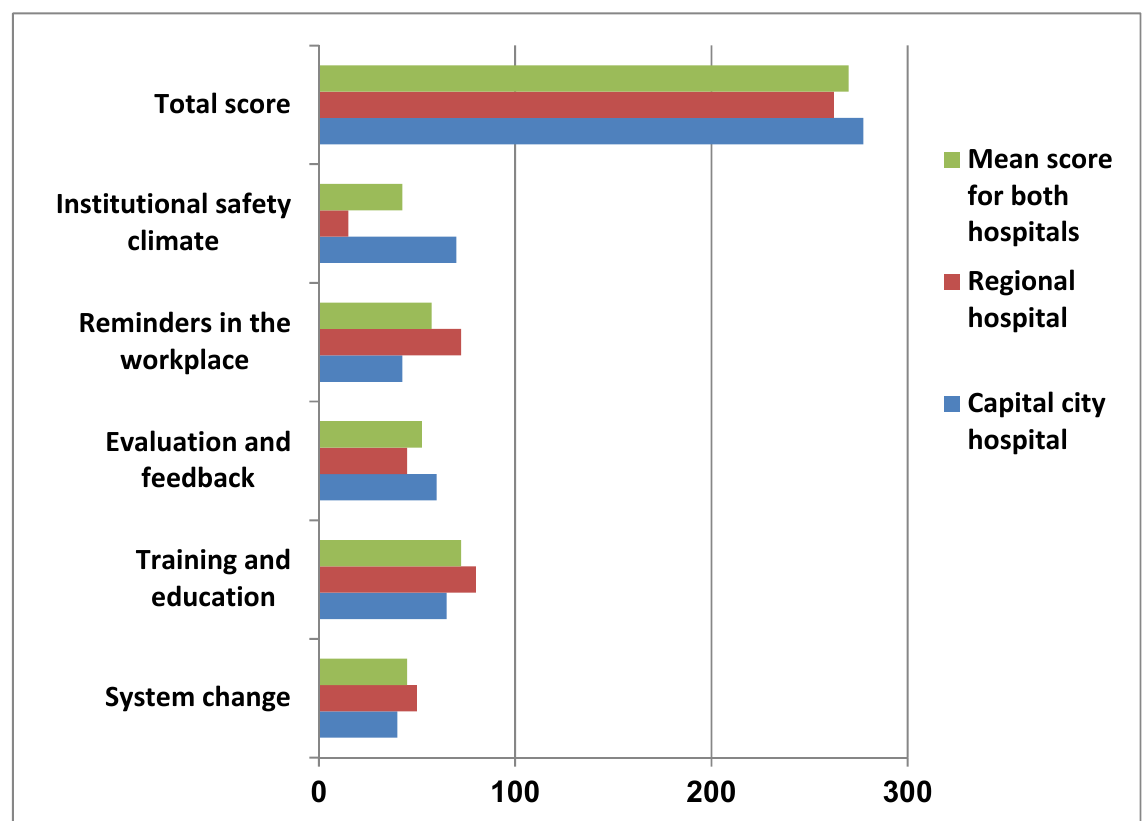
Figure 2. Hand hygiene levels of the two hospitals.